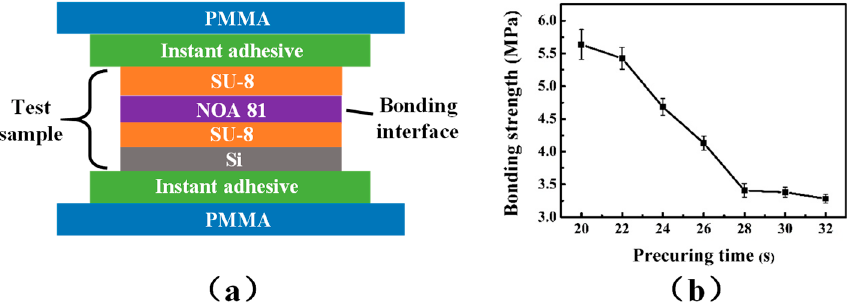
Figure 7. ( a ) Schematic diagram of the sample used for bonding strength test; ( b ) the precuring time- strength curve. time-strength